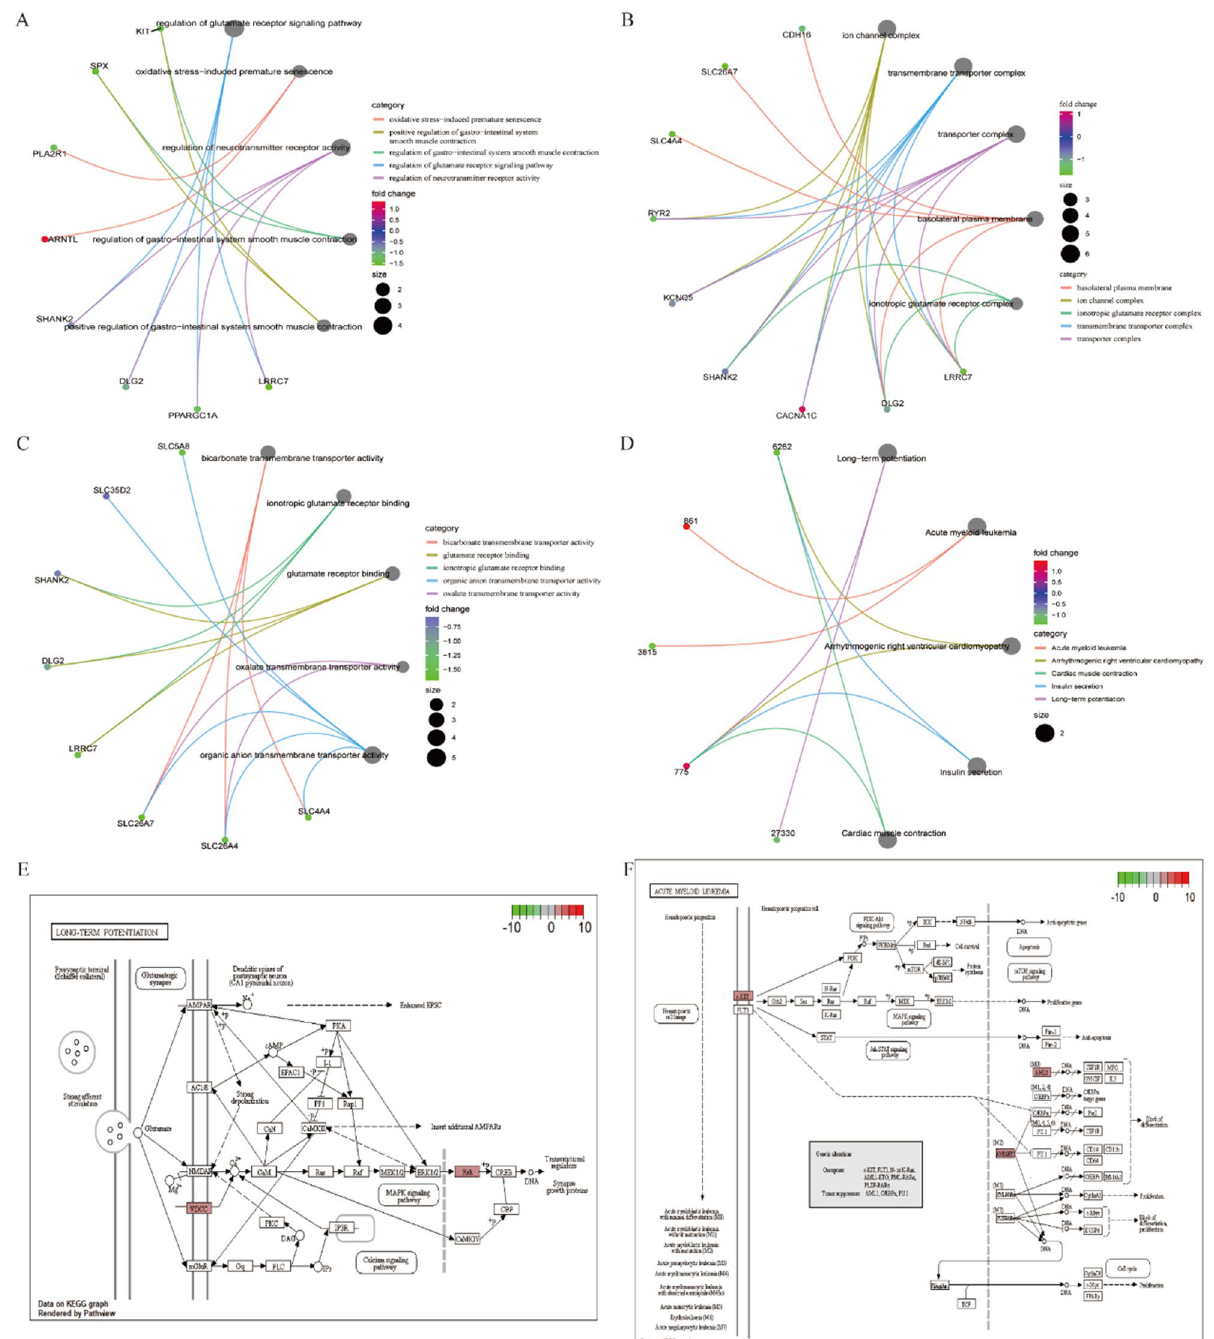
Figure 3. Functional enrichment analysis of trans-target genes based on differentially expressed lncRNAs. ( A – C ) Based on the three GO classifications (CC, BP, and MF), our analysis suggests that the expression of trans-target genes is associated with the regulation of glutamate receptor signaling pathway, ion channel complex, and bicarbonate transmembrane transporter activity BP terms. ( D ) KEGG enrichment analysis shows that the expression of trans-target genes is significantly associated with different pathway terms, such as long- term potentiation, acute myeloid leukemia, and other pathways. ( E , F ) Visual display of changes in the relevant enriched